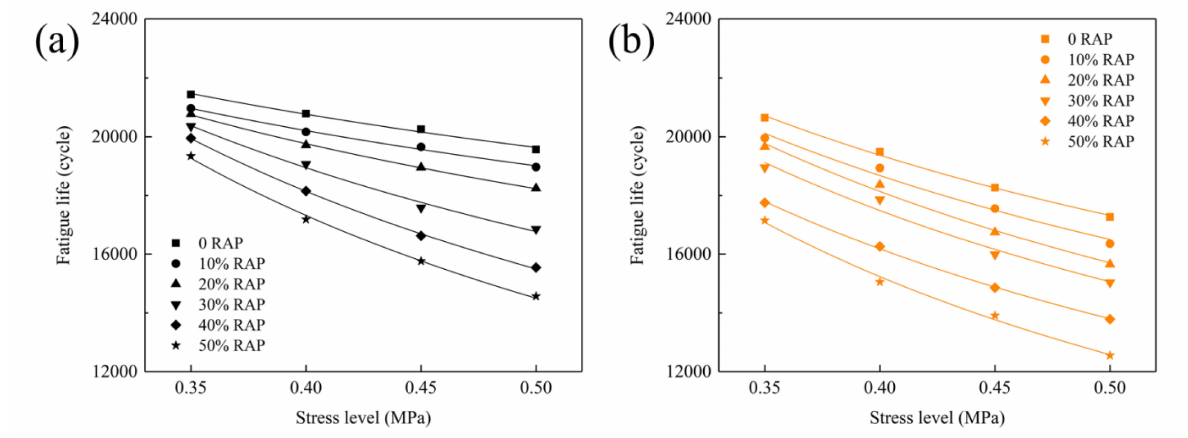
Figure 9. Fatigue life curve of RAM: ( a ) steel slag; ( b ) basalt.